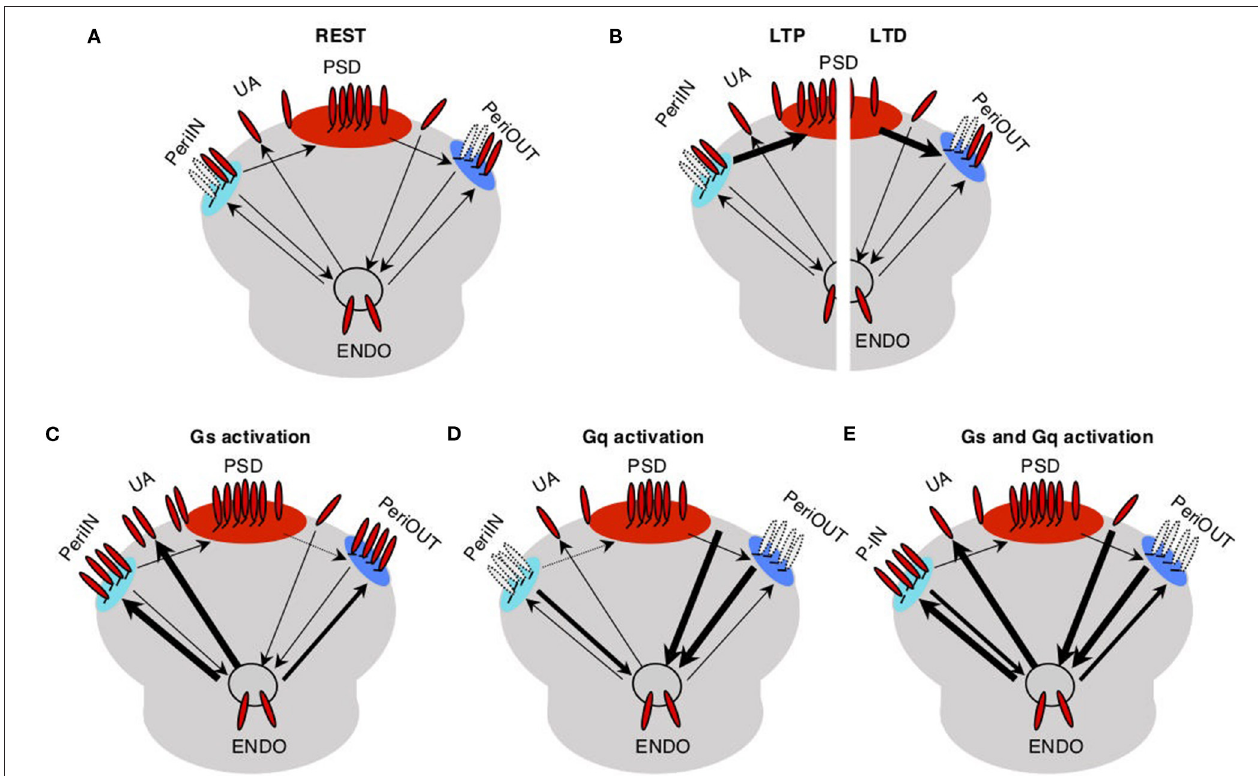
FIGURE 1 | Trafficking model of neuromodulation of Hebbian plasticity. AMPA receptors (red) at the synapse are either anchored at the postsynaptic density compartment (PSD) and in two close compartments (PeriIN, PeriOut), or unanchored. (A) Traffic between these synaptic compartments and with an endoplasmatic compartment (Endo) is low at rest (thin arrows). (B) Traffic between PSD and P-In, P-Out increases during long-term potentiation (LTP; left) and long-term depression (LTD; right) induction (thick arrows). (C) Activation of Gs increases traffic out of the Endo toward the synapse saturating both P-In and P-Out, thus preventing LTD. (D) Activation of Gq increases traffic out of the synapse toward the Endo compartment depleting both P-In and P-Out, thus preventing LTP. (E) Activation of both Gs and Gq increases the exchange between the synaptic and the Endo compartments, thus enabling/facilitating both, LTP and